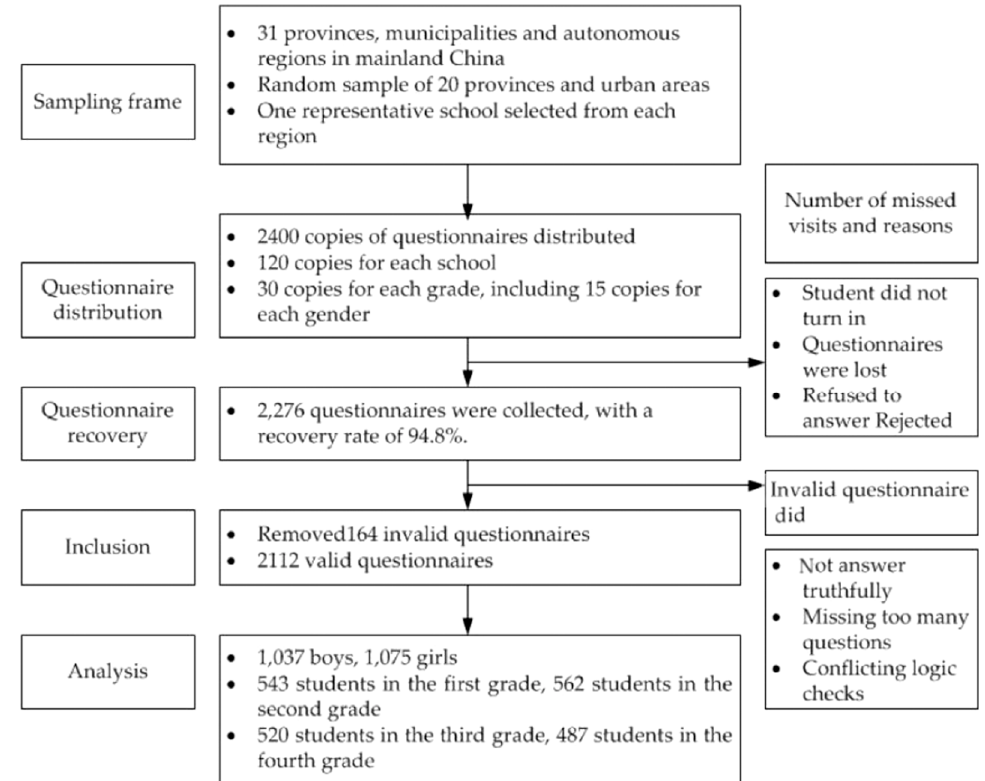
Figure 3. Flow chart .